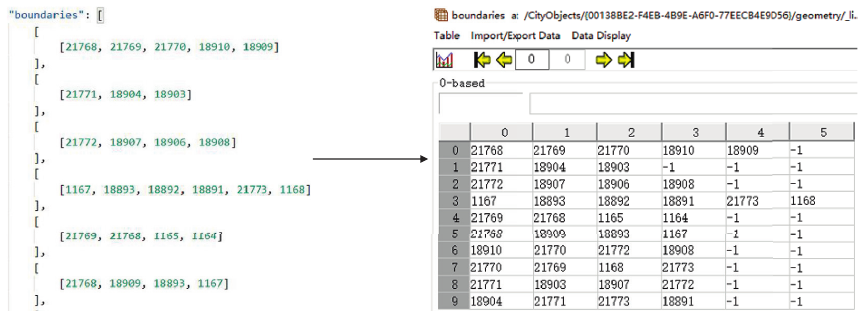
Figure 12: Original form in JSON (left) and resultant form in HDF (right) in boundary case.